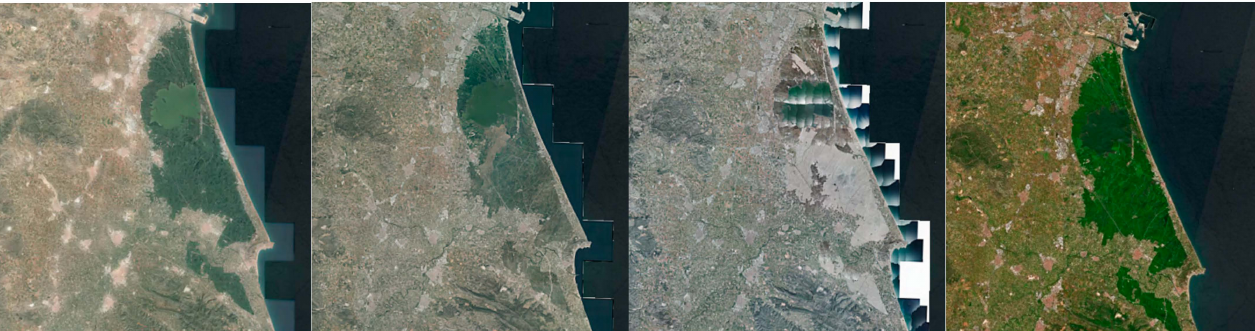
Figure 15. Sequences of satellite images of the area of study of the Albufera of Valencia Regional Park for 2005, 2010, 2015 and